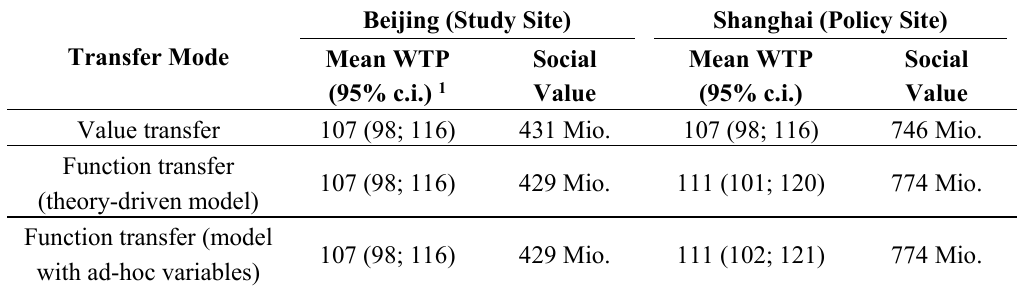
Table 5. Willingness to pay in RMB of Beijing and Shanghai residents (benefit